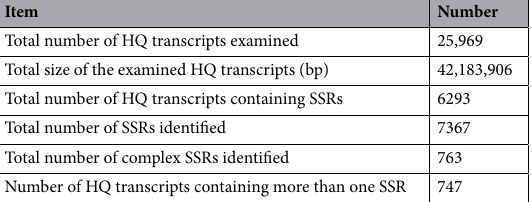
Table 2. Occurrence of microsatellites in the full-length transcriptome of P. catalpifolia.